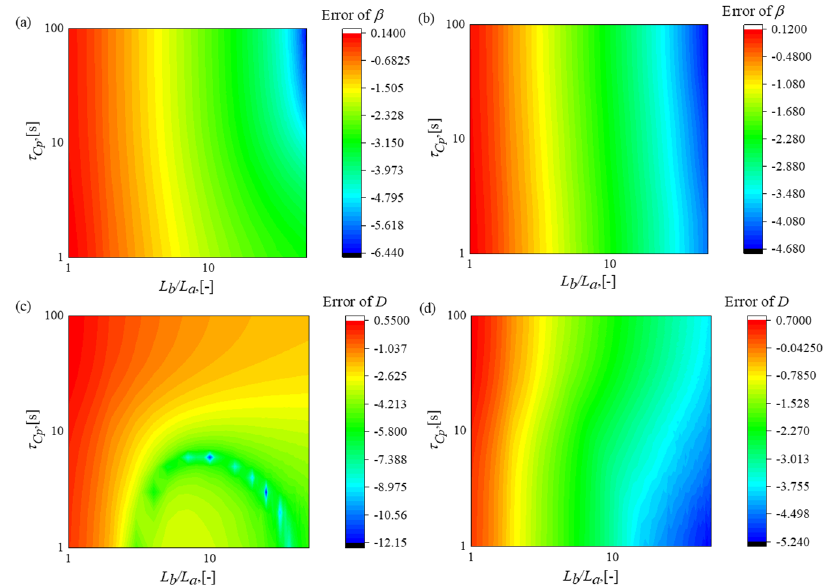
Figure 10. Contour maps of errors with different width-to-thickness ratios and carbon potential build-up durations. ( a ) error of β (Bi = 0.01), ( b ) error of β (Bi = 1), ( c ) error of D (Bi = 1), ( d ) error of D (Bi = 100)